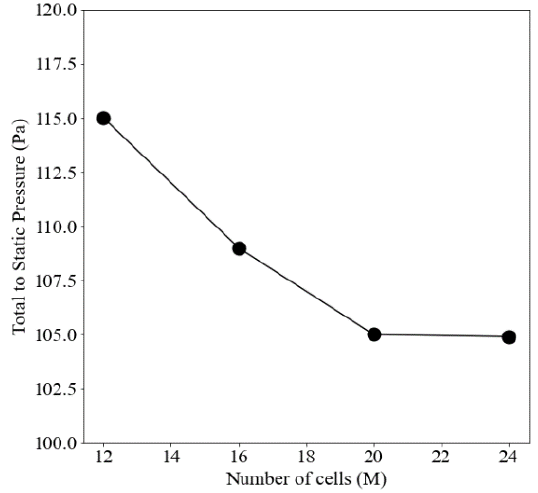
Figure 5. TTS pressure as a function of the number of cells, datum blade.